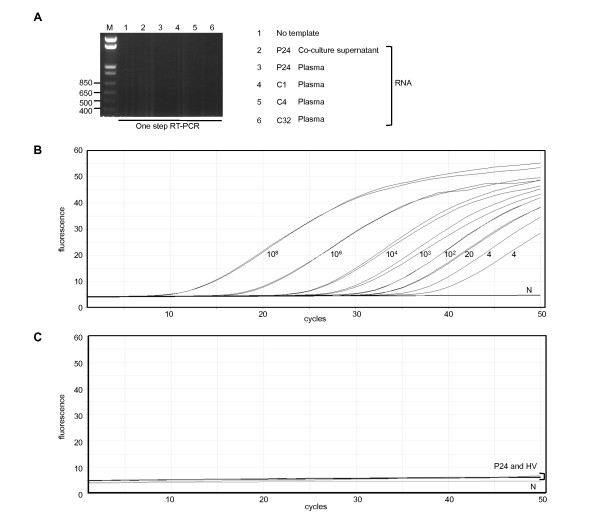
Detection of XMRV RNA and DNA in viral Ab-positive samples. (A) RNA was purified from 1 mL of coculture supernatant of activated PBMCs and LNCap-FGC cells (lane 2) or 1 ml plasma (lanes 3-6). For one-step RT-PCR, 15 μl of 60 μl eluted RNA was amplified in a 25 μl volume. CFS patients C4 and C32 tested positive for XMRV Abs but C1 was negative. (B) Detection of XMRV env by TaqMan real-time PCR assay. Duplicated test samples of diluted XMRV plasmid (VP62) were amplified. The detection limit of the TaqMan real-time PCR was 4 copies/reaction determined by VP62 plasmid. (C) Duplicated test samples without template DNA in negative control (N) or with genomic DNA extracted from PBMCs of a viral Ab-positive PC patient (P24) and healthy volunteers (HV) were amplified as for (B).